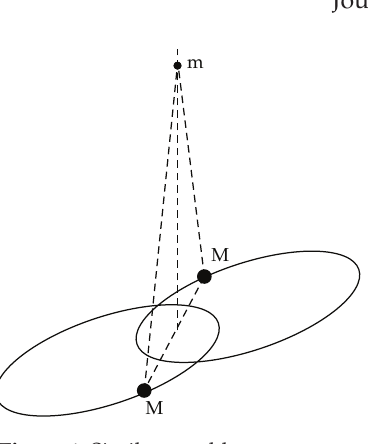
Figure 1: Sitnikov problem